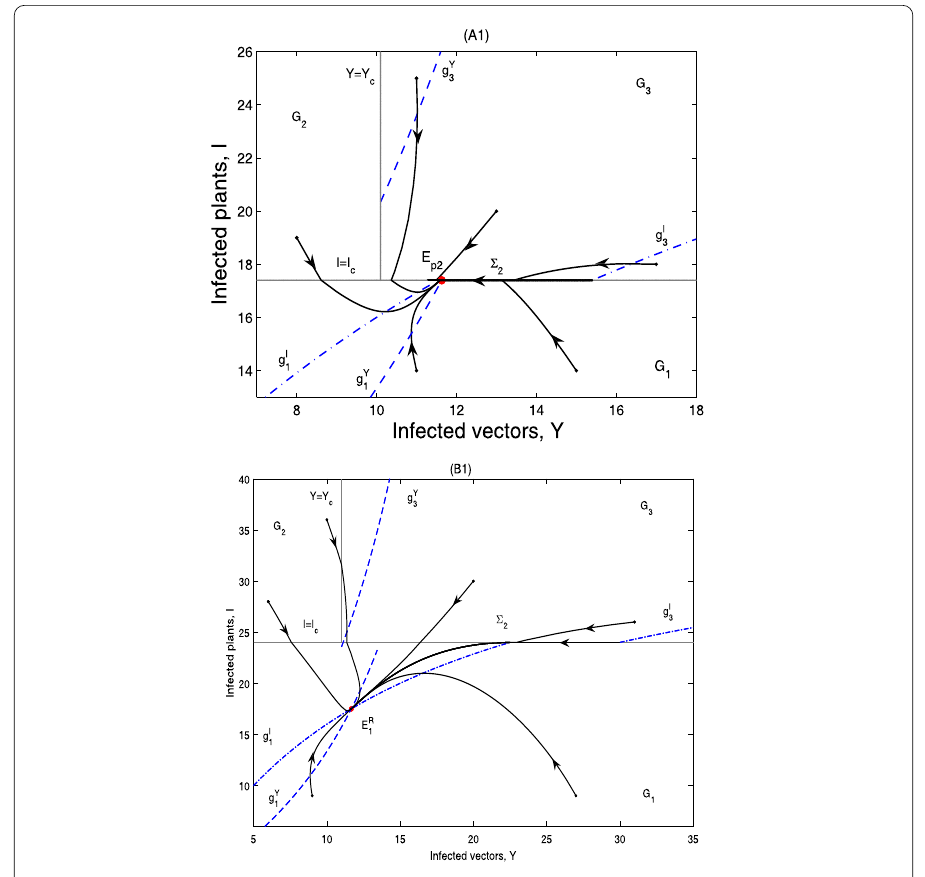
Figure 12 Global dynamics in Case C.3. ( A1 ) E p 2 is globally asymptotically stable. Y c = 10.1, I c = 17.4. Σ 3 does not exist. ( A2 ) E p 2 is globally asymptotically stable. Y c = 10.5, I c = 17. Σ 3 = { ( Y , I ) ∈ Ω 2 : I c < I < g 2 } . ( B1 ) E R 1 is globally asymptotically stable. Y c = 11, I c = 24. Σ 3 does not exist. ( B2 ) E R 1 is globally asymptotically stable. Y c = 11, I c = 19. Σ 3 = { ( Y , I ) ∈ Ω 2 : I c < I < g 2 } . (A2) and (B2) are omitted